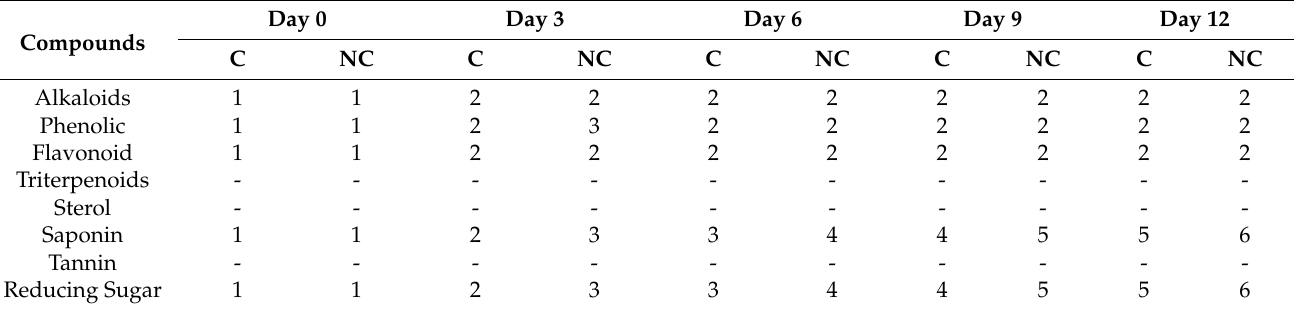
C: coated tomato; NC: non-coated. * The highest number represents the highest content of phytochemicals and reducing sugar in the sample. The increase in phenolic content was observed on the third day (5.88 mg GAE/g and 5.60 mg GAE/g, for non-coated and coated tomatoes, respectively) and started to reduce on the sixth day of storage (5.43 mg GAE/g and 5.51 mg GAE/g for non-coated and coated tomatoes, respectively (Figure 2A). Even though the phenolic compound of coated tomatoes was lower compared to the non-coated, = there was no significant difference found. The decline in phenolic content in non-coated tomatoes was higher compared to the coated group. The phenolic content in climacteric fruit was lessened during the ripening process [56]. Meanwhile, the rise in phenolic contents could be due to the breakdown of cell wall components. Therefore, the phenolic compounds initially located in the vacuole in the form of bound phenolics become accessible as free phenolics [57]. As a result, the total phenol of the coated tomatoes was slightly lower than the non-coated group. This result is in line with a previous report by Riaz et al. [58], where the phenolic content of non-coated fruit was higher compared to the coated group. The edible coating acts as a barrier from the surrounding environment, which could inhibit the catabolism reaction used for energy for the ripening stage. A previous report suggested that the decrease in phenolic compounds can also be due to the autoxidation reaction of phenol compounds by oxygen and light [59].